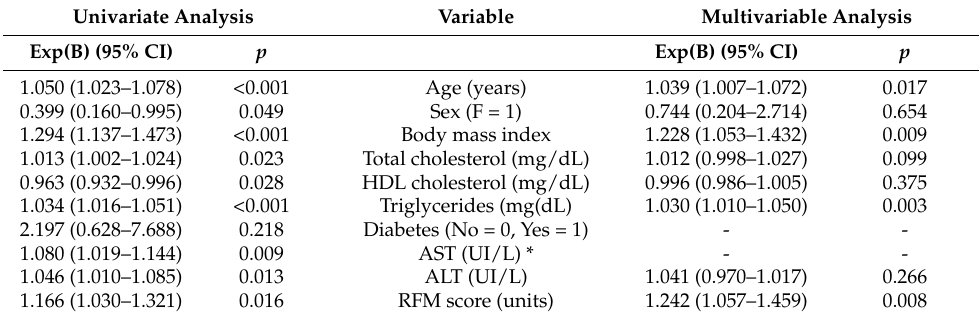
Table 3. Univariate and multivariate binary logistic regression to nonalcoholic fatty liver disease.